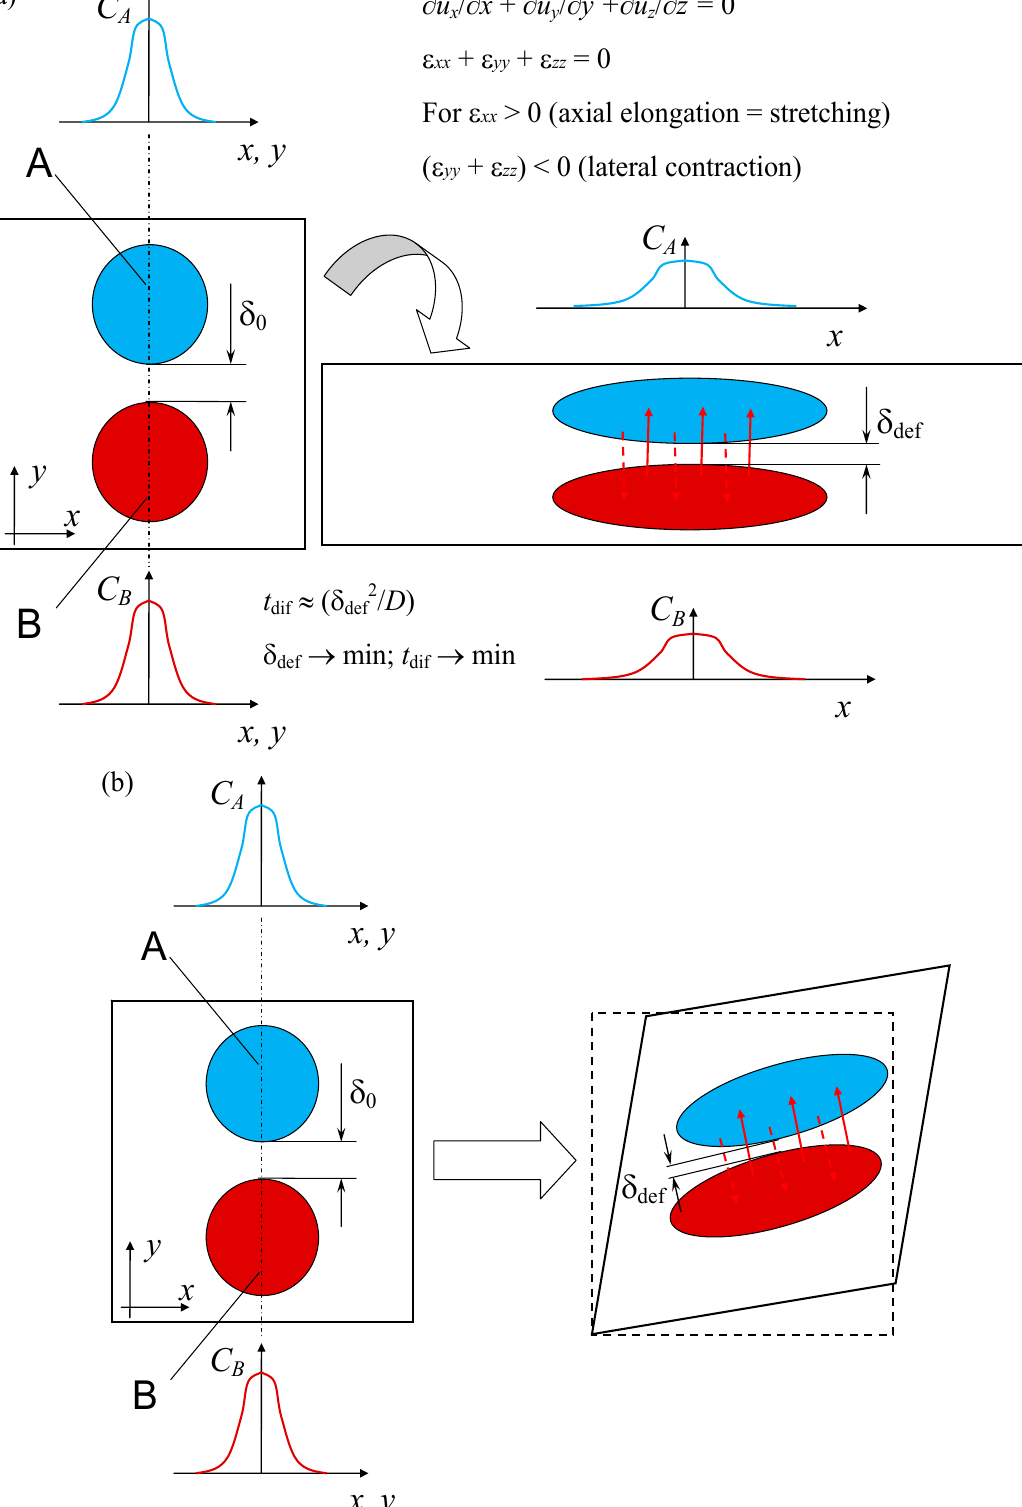
Figure 3. Schematic of the influence of linear ( a ) and angular ( b ) deformations on the process of diffusion of substance spots (concentration spots). The plot is based on the [26] approach.